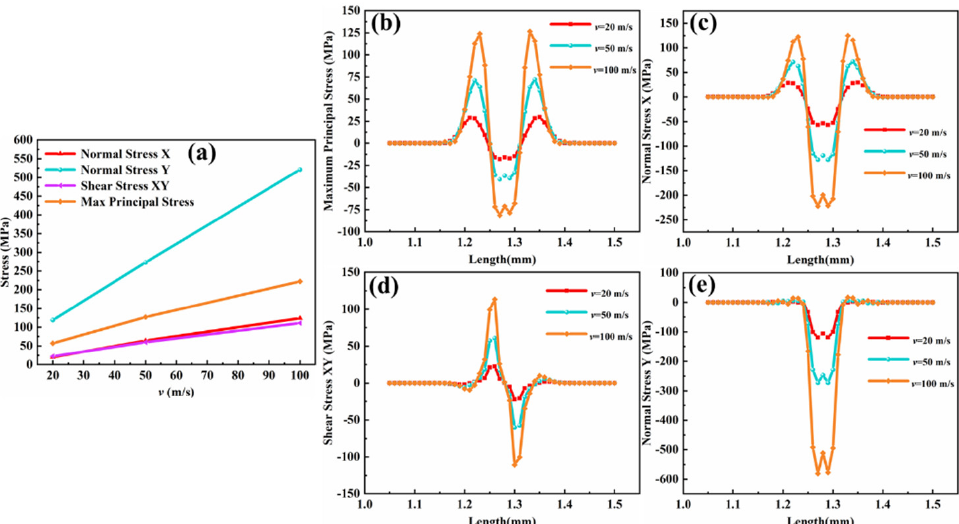
Figure 9. ( a ) The maximum stress as the function of the impact velocity, ( b ) maximum principal stress, ( c ) normal stress X, ( d ) shear stress XY and ( e ) normal stress Y as the function of the length.